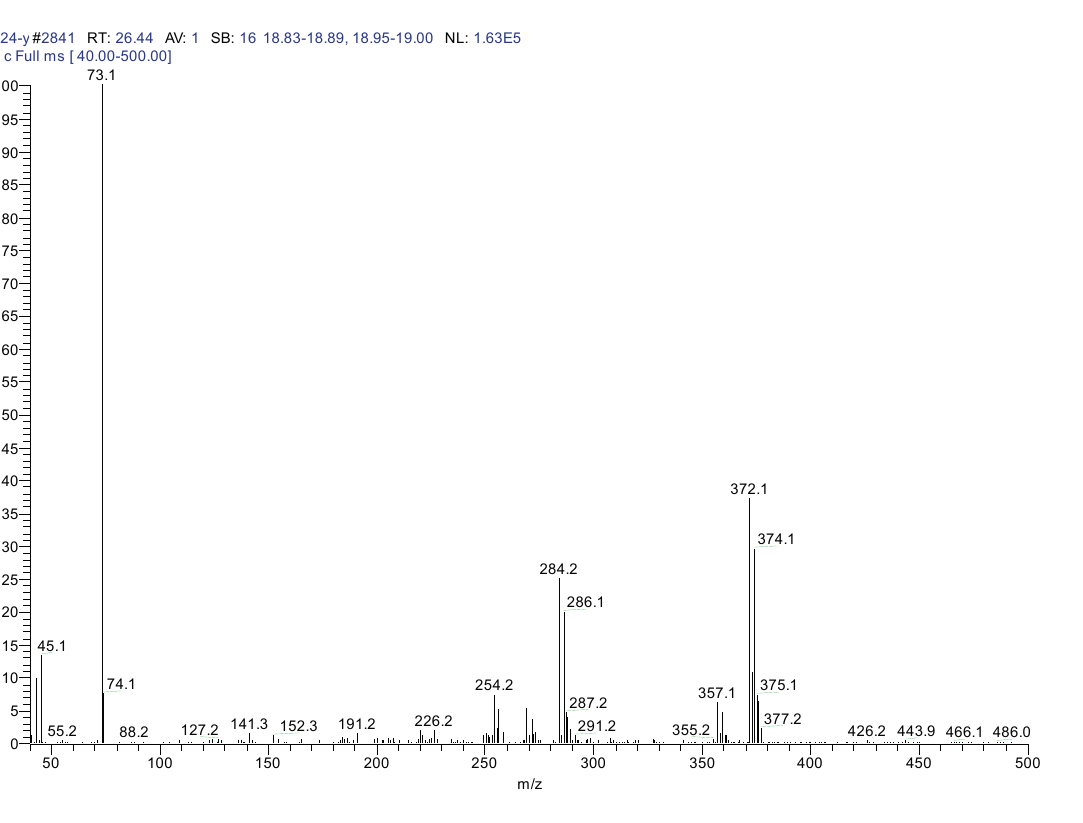
Figure 11. MS spectrum of a silane-derivatized sample at peak 22.4 min.